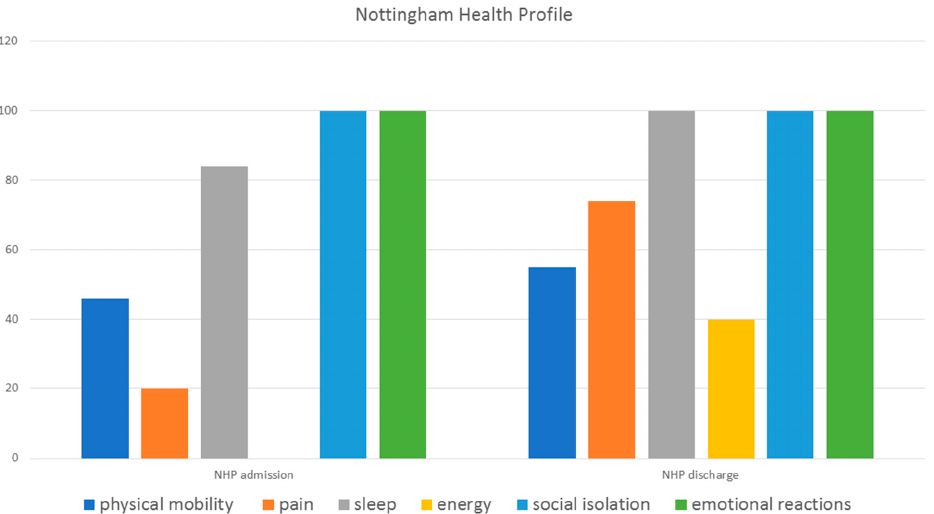
Figure 4. The quality of life on admission and discharge from the hospital measured with the Nottingham Health Profile (NHP).